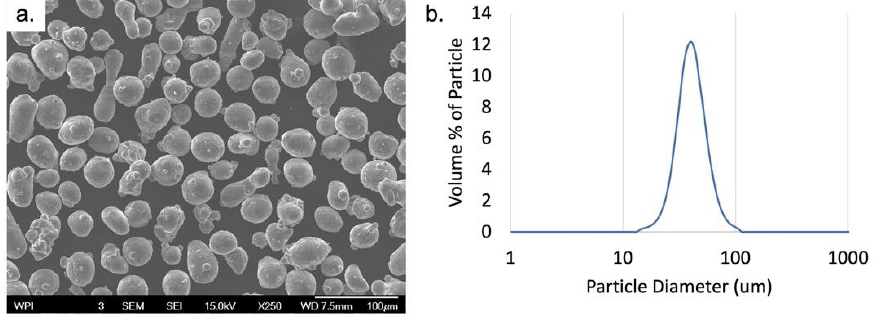
Figure 1. ( a ) BSE images of loose Al 6061 powder and ( b ) particle size distribution of Al 6061 powder. Cross-sectional micrographs of the feedstock powder in (a) the as-atomized condition and (b) the thermally treated condition taken using a backscatter electron (BSE) detector are shown in Figure 2. In both, the light-contrasting regions correspond to the Fe-rich phases whereas the dark-contrasting regions are Mg 2 Si as determined by the reference [17]. In with small Mg 2 Si, primarily at the grain corners. This is typical of other gas-atomized Al 6061 powders that have been analyzed in literature [8,16,17,26]. In the thermally treated